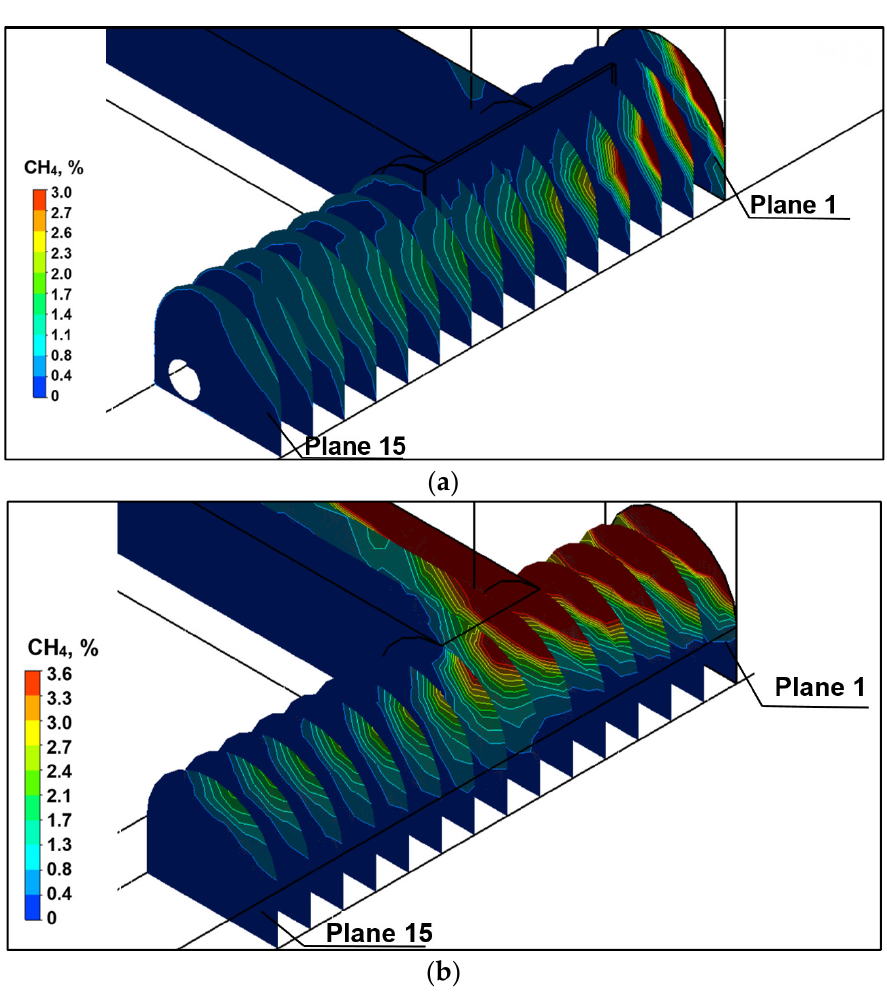
Figure 9. The distributions of methane concentrations in vertical sections of the tailgate with built-in AVE ( a ) and without such equipment ( b ).